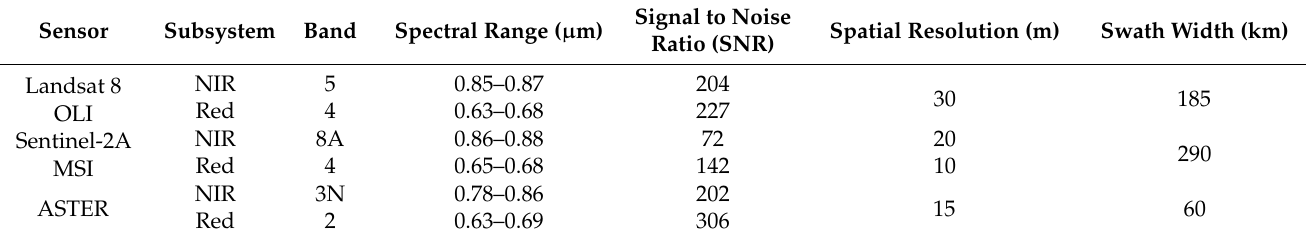
Table 1. Parameters of bands for NDVI computation from Landsat 8, Sentinel-2A, and ASTER.